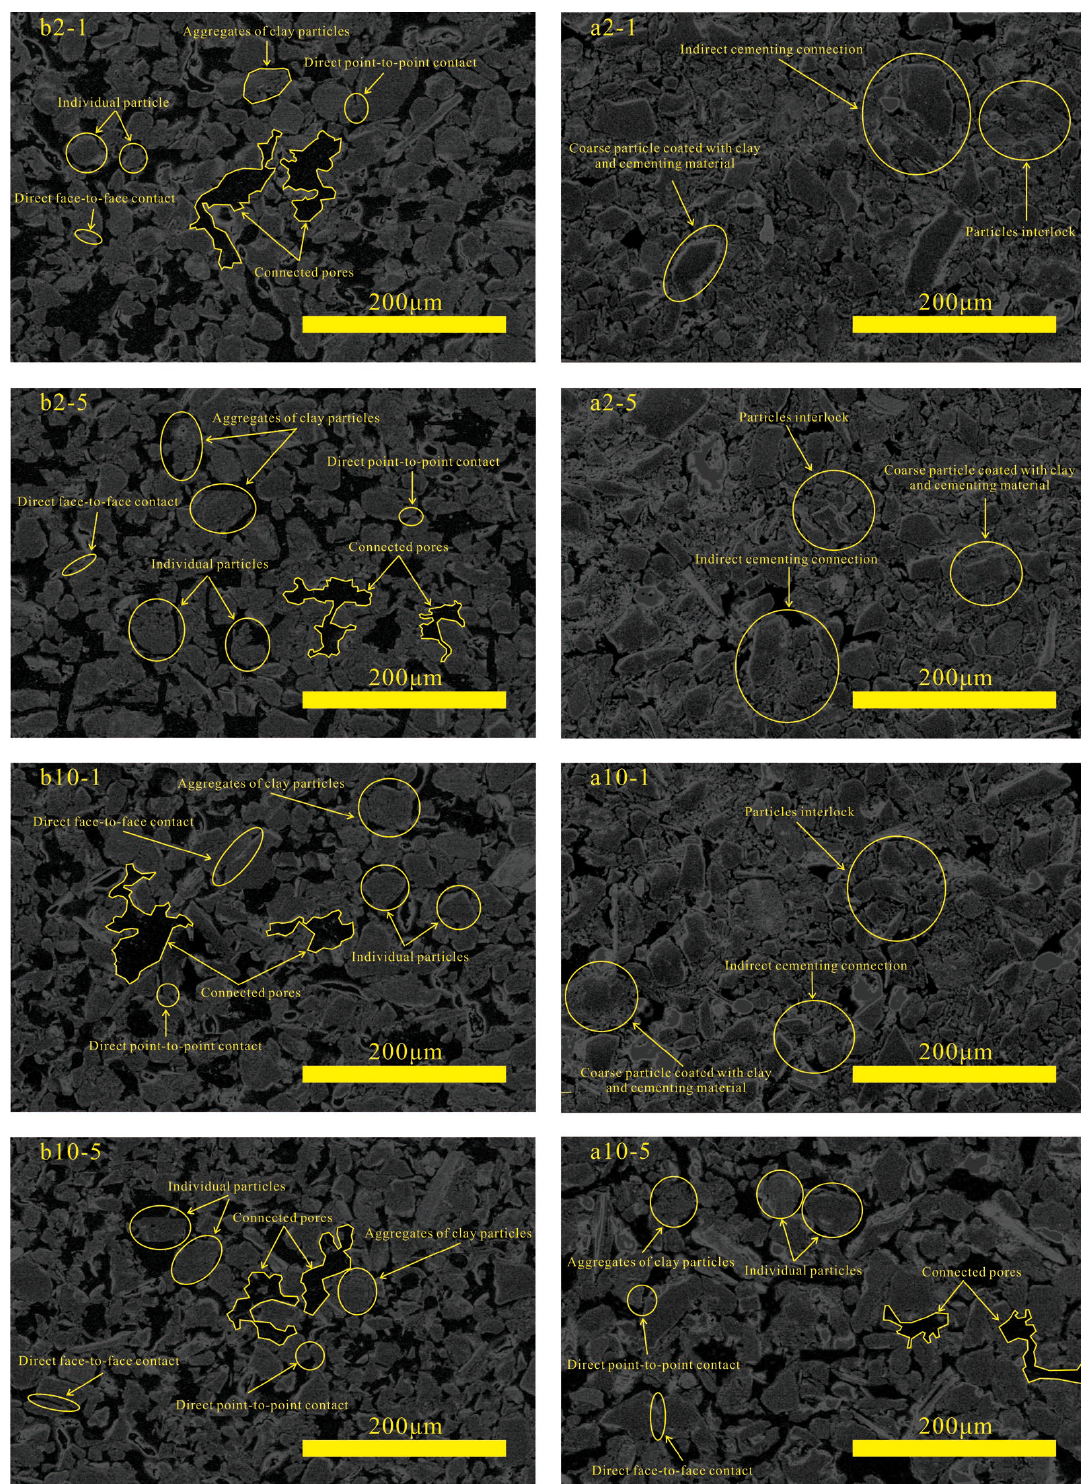
Figure 10. SEM images of remolded loess samples: letter b and a represent before and after compression, respectively; numbers after the letter represent the sample height; numbers after the horizontal line represent the position of the cylindrical specimen in the remolded sample.